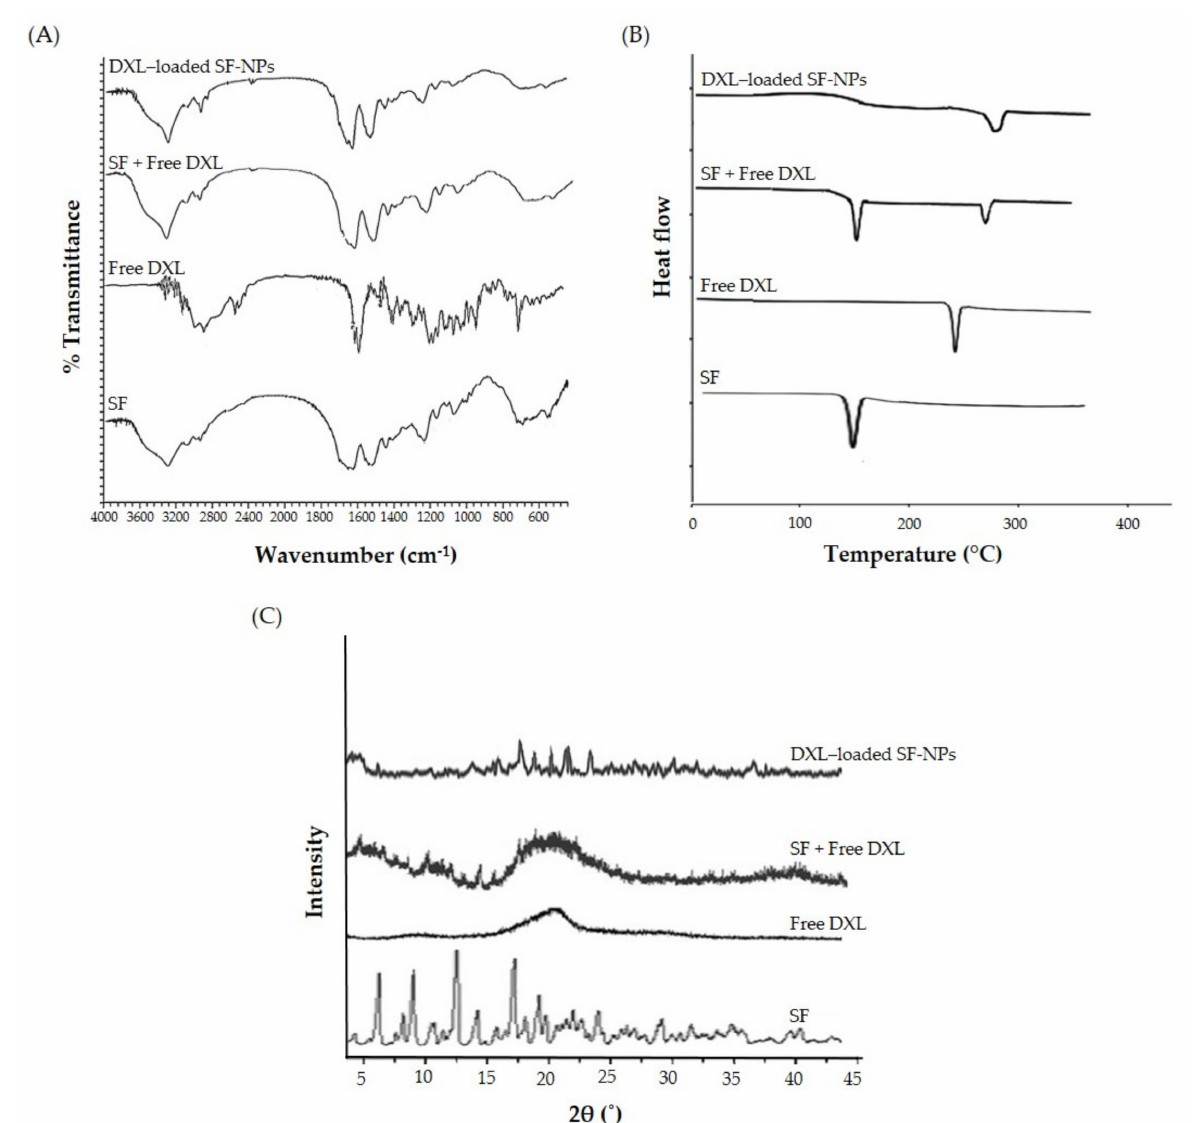
Figure 2. Physicochemical characterization of DXL-loaded SF-NPs. ( A ) Fourier-transform infrared spectra, ( B ) differential scanning calorimetry thermograms, and ( C ) X-ray diffraction